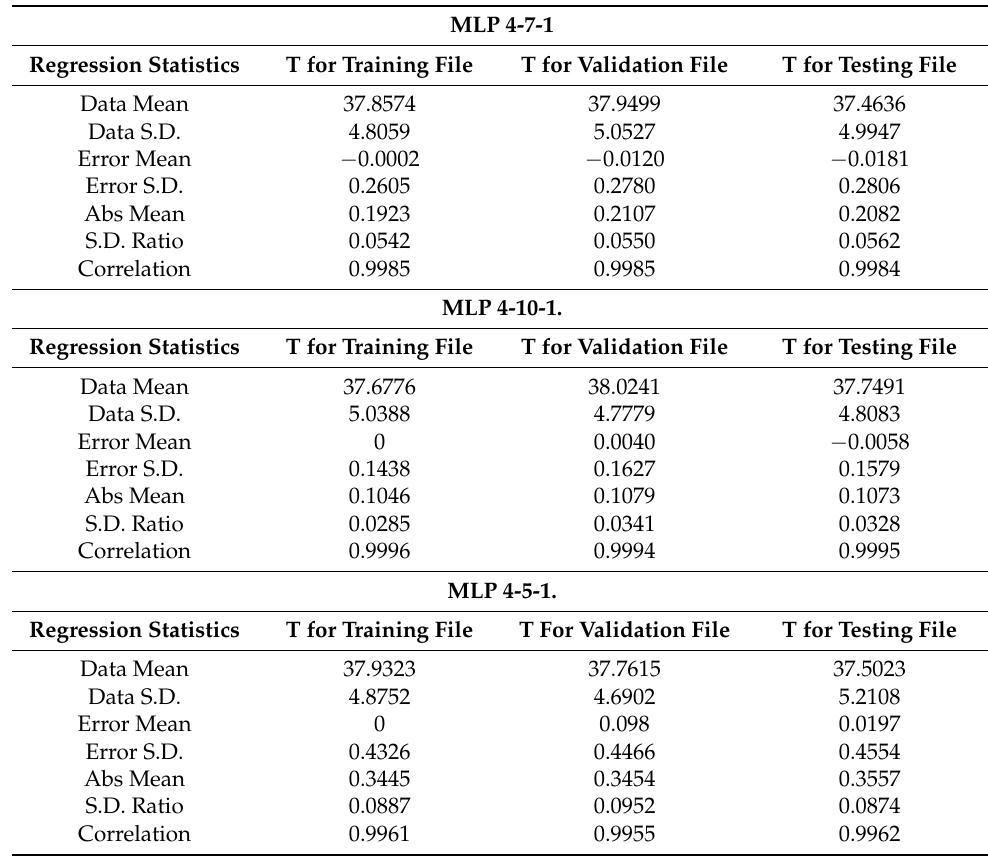
Table 3. Regressive statistics both for the selected model and the rejected models, for training set, validation set and testing set,